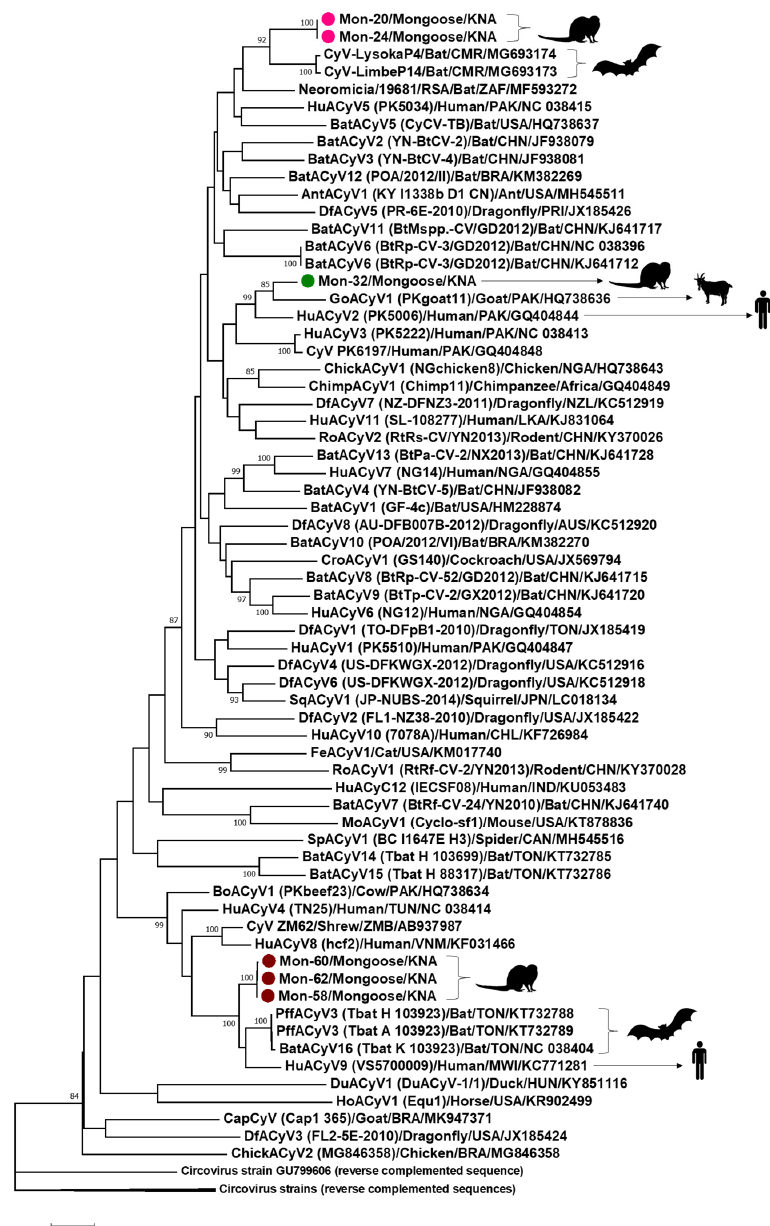
Figure 6. Phylogenetic analysis of the complete genomes of mongoose associated cycloviruses (Mon-20, -24, -32, -58, -60 and -62) with those of other cycloviruses. The virus name/source (detected in animal species)/country are shown for the Mon sequences, while the species, or virus name (isolate)/source (detected in animal species)/country/GenBank accession number have been mentioned for the other cyclovirus sequences. The tree was constructed by the maximum likelihood (ML) method, with the GTR+G model of substitution and 1000 bootstrap replicates and rooted after using circovirus reverse complemented sequences as the outgroup. Scale bar, 0.2 substitutions per nucleotide. Bootstrap values of <80 are not shown. Mon-20 and -24 are shown with pink circles, Mon-32 is highlighted with a green circle, whilst Mon-58, -60 and -62 are indicated with brown circles. AntACyV: ant associated cylcovirus; BatACyV: bat associated cyclovirus; BoACyV: bovine associated cyclovirus; ChickACyV: chicken associated cyclovirus; ChimpACyV: chimpanzee associated cyclovirus; CroACyV: cockroach associated cyclovirus; CyV: cyclovirus; DfACyV: dragonfly associated cycovirus; DuACyV: duck associated cyclovirus; FeACyV: feline associated cyclovirus; GoACyV: goat associated cyclovirus; HoACyV: horse associated cyclovirus; HuACyV: human associated cyclovirus; MoACyV: mouse associated cyclovirus; PffACyV: Pacific flying fox associated cyclovirus; RoACyV: rodent associated cyclovirus; SpACyV: spider associated cyclovirus; SqACyV: squirrel associated